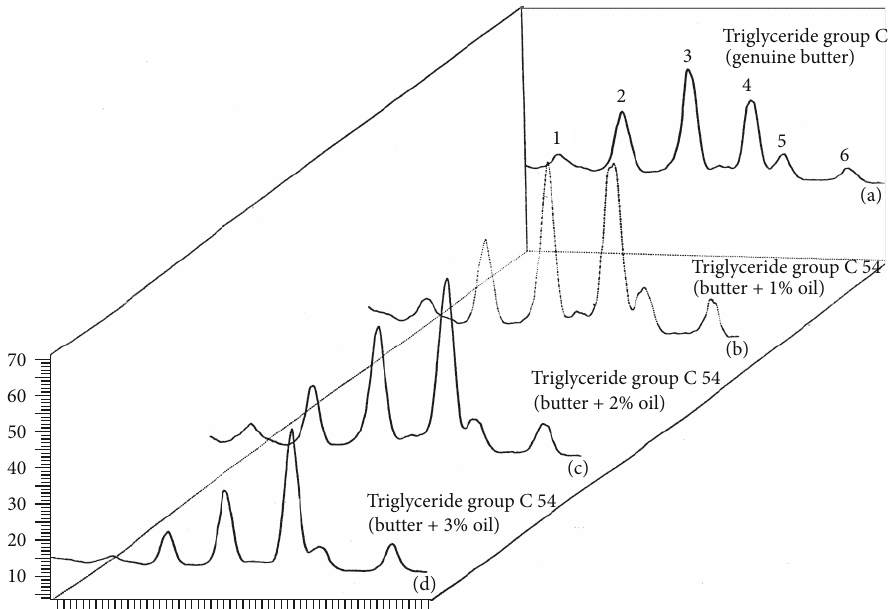
Figure 3: Gas chromatogram of the C54 family in authentic butter (a) and butter containing 1.02% (b), 2.24% (c), and 3.29% (d) (w/w) of added olive oil.